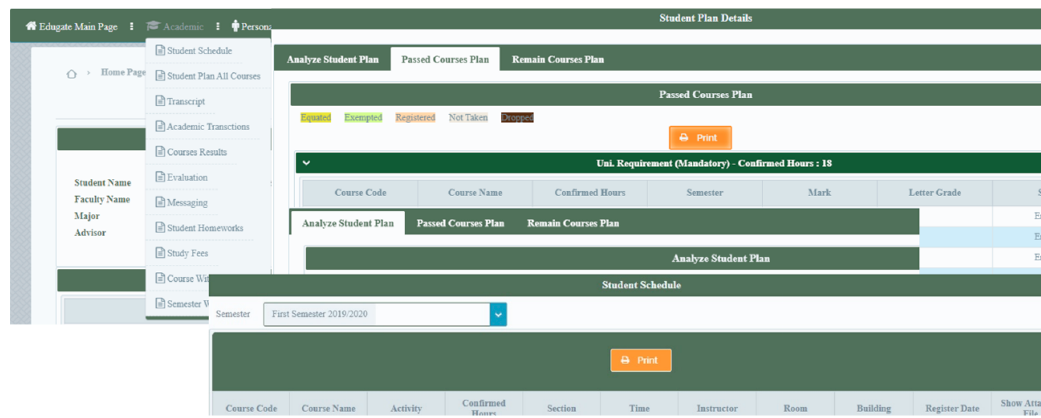
Figure 3. The structure of EAR—Example 2.